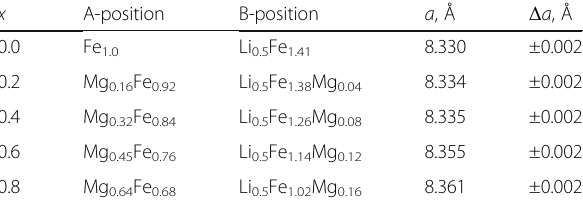
Table 1 Cation distribution of synthesized samples Li 0.5 Fe 2.5-x Mg x O 4